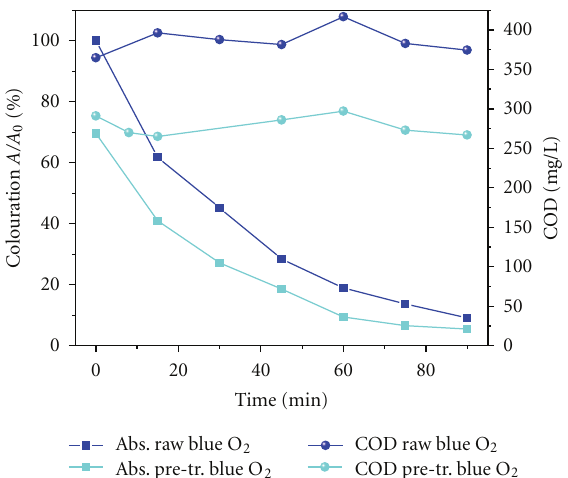
Figure 6: Colouration expressed as A/A 0 and COD values of Reactive Blue 19 wastewater samples at di ff erent times of PCOx irra- diation. Square symbols in all graphs represent absorbance values of untreated and pretreated samples; sphere symbols represent COD values of the same samples.